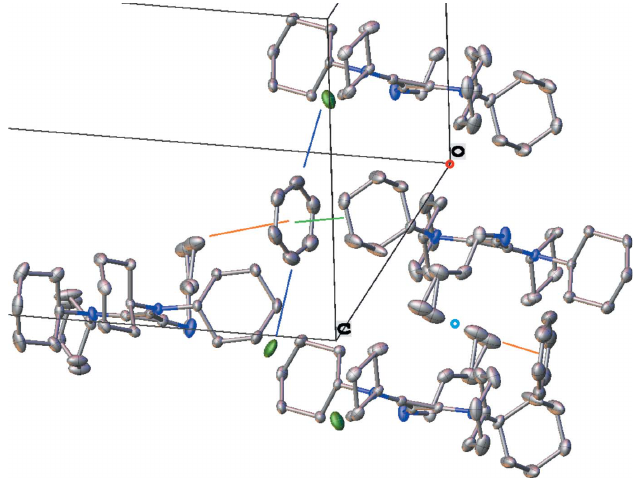
Figure 3 Partially packed thermal ellipsoid plot of [ 1 H]Cl (cid:2) C 6 H 6 showing neighboring intermolecular/interionic nearest neighbor